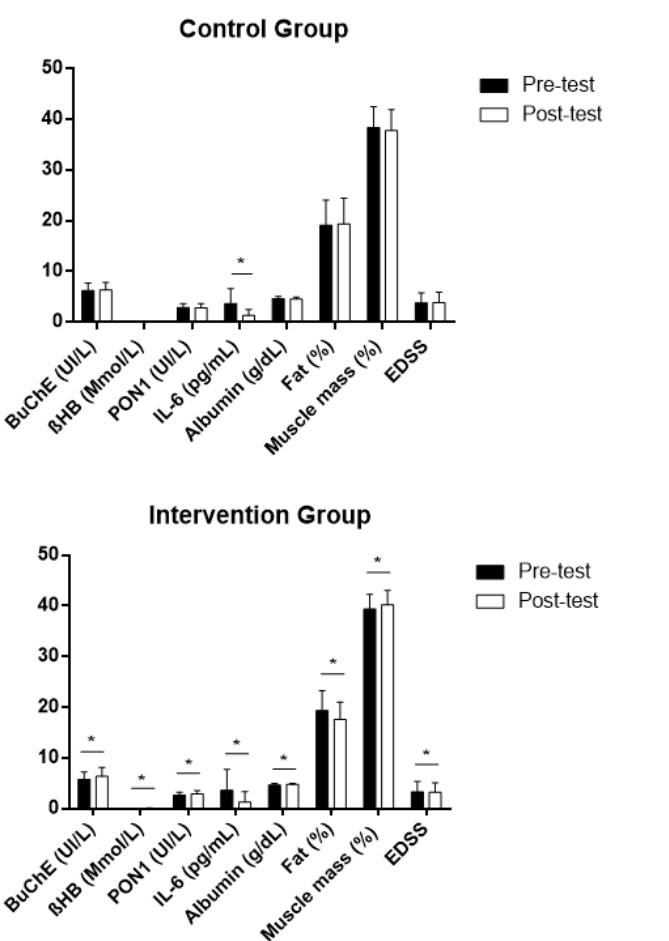
Figure 4. Intragroup differences in the study variables after intervention (post-test) expressed in average values ± standard deviation, both in the intervention and the control groups. BuChE: butyrylcholinesterase; β HB: β -hydroxybutyrate; PON1: paraoxonase 1; IL-6: interleukin 6; Fat (%): body fat percentage; Muscle mass (%): body muscle percentage; EDSS: Expanded Disability Status Scale; Z: Wilcoxon signed-rank test. * Statistically significant differences, p < 0.05.